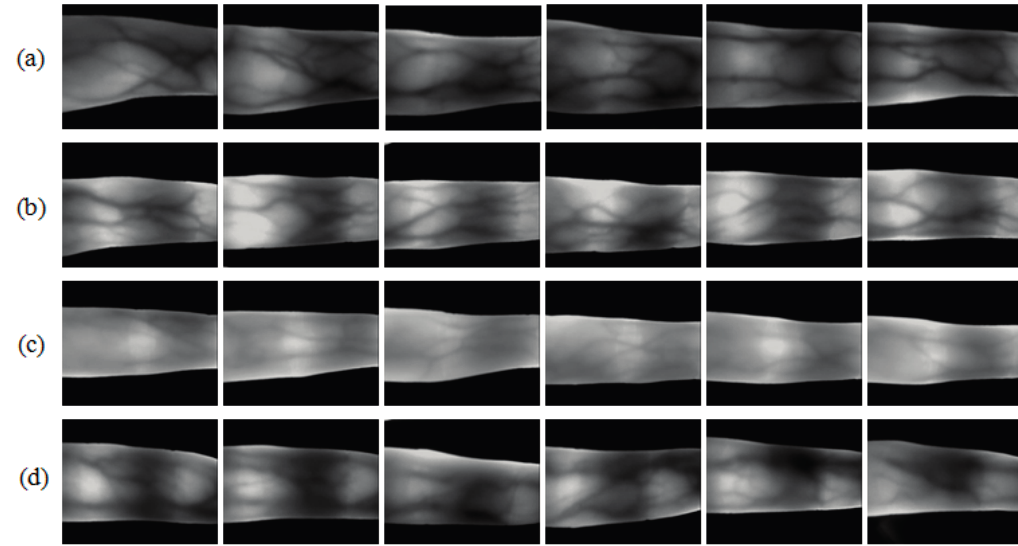
Figure 2. Image samples from our available database MMCBNU_6000 [21]: ( a – d ) are finger vein image samples collected from four volunteers P1–P4, respectively. Each row shows six images from six different fingers of one